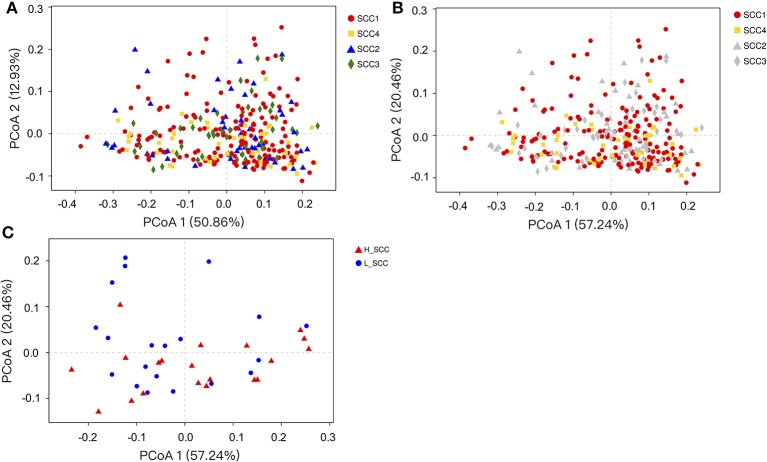
Principal coordinates analysis (PCoA) based on weighted Unifrac distances of OTUs. Samples are indicated by points and colored for different SCC groups. (A) PCoA of the four SCC groups. (B) PCoA of the four SCC groups with SCC1 and SCC4 highlighted. (C) PCoA of L_SCC and H_ SCC groups.